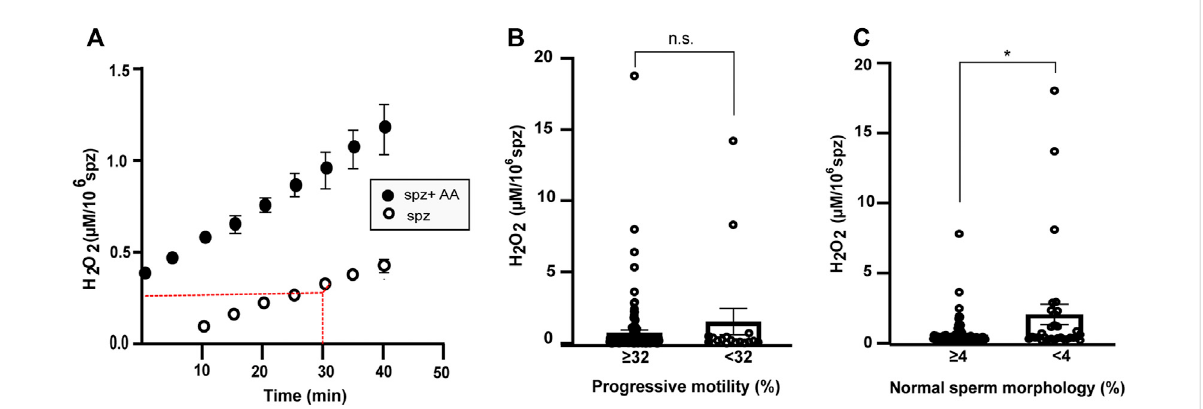
FIGURE 3 Production of extracellular H 2 O 2 in s perm cells. (A) Production of peroxide by 10 6 sperm cells (spz) from normozoospermic samples as a function of time using detection of resoru fi n fl uorescence emission by Amplex Red assay. Comparison between sperm samples under control conditions(white)andinthepresenceofantimycinA(AA)(black). (B,C) GraphsshowH 2 O 2 concentrationafter30 mininspermsamplesclassi fi edby progressive motility cut off ( ≥ 32% N = 119; < 32% N = 17) (B) or percentage of normal and abnormal sperm morphology ( N = 104 and N = 31, respectively, cut off = 4) (C) . Error bars represent SEM. A Mann-Witney test was used to evaluate statistical signi fi cance. n.s. P > 0.05, * p <